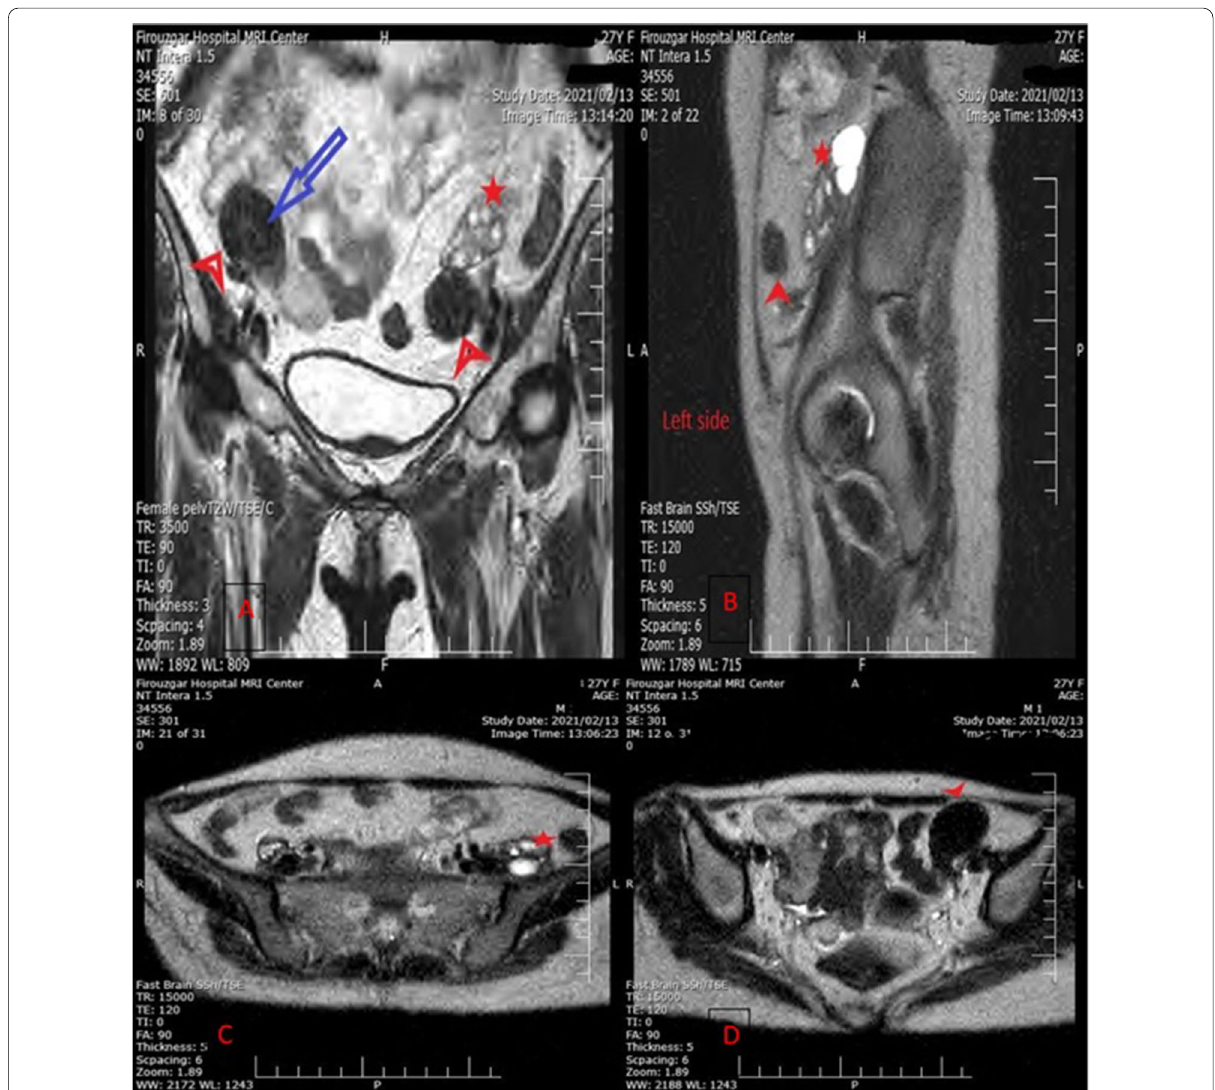
Fig. 2 Coronal and sagittal T2‑weighted images in ( a , b ) show retroperitoneal low signal structure (red arrow head) under left iliac artery bifurcation, in favor of completely separate uterus with separate hypoplastic cervix, Coronal, sagittal and axial T2‑weighted images in ( a – c ) show retroperitoneal structure with a few intralesional cystic components with morphology similar to left ovary (*) in pelvic inlet level, d left horn of didelphis uterus is shown in axial view (red arrow